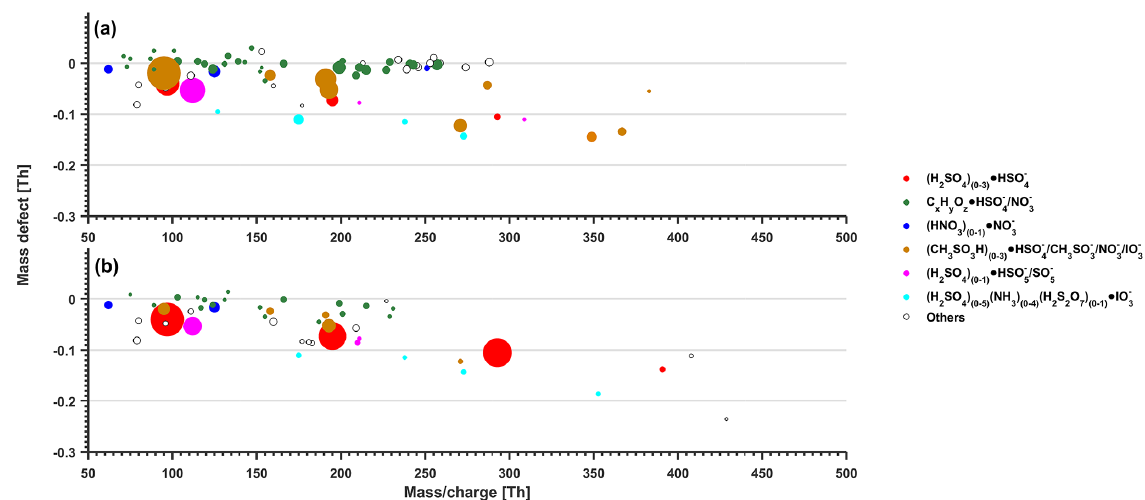
Figure 4. Comparison of two different nighttime spectra in negative mode between 22:00 and 02:00LST. (a) Typical night spectrum, exemplified for the night from 9 to 10 March 2014. (b) Spectrum with high sulfuric acid signal in the night from 11 to 12 November